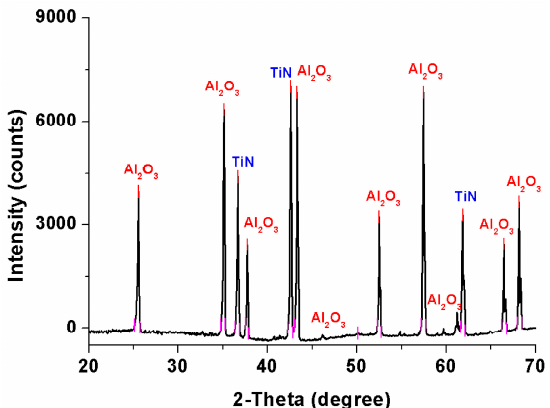
Figure 5. A representative X-ray diffraction pattern of an as-sintered Al 2 O 3 –TiN ceramic composite.